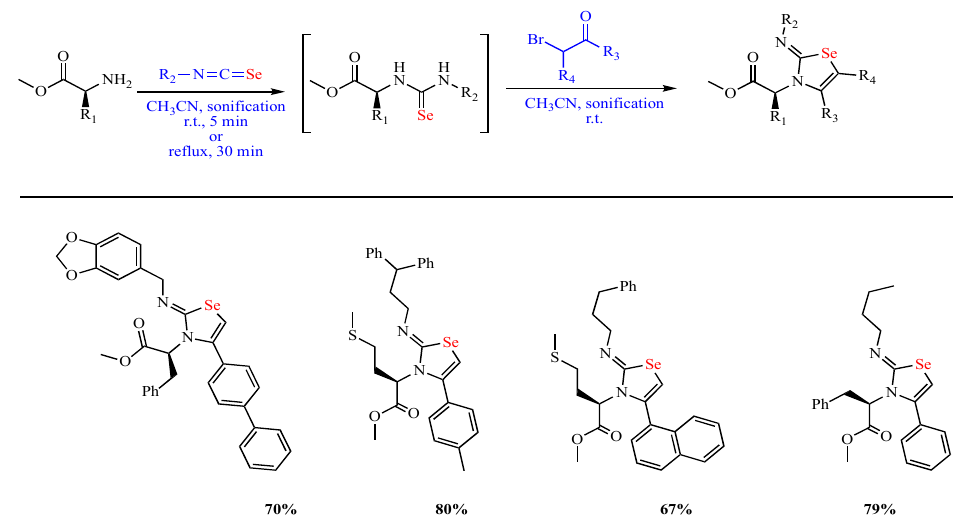
Scheme 40. Synthesis of chiral